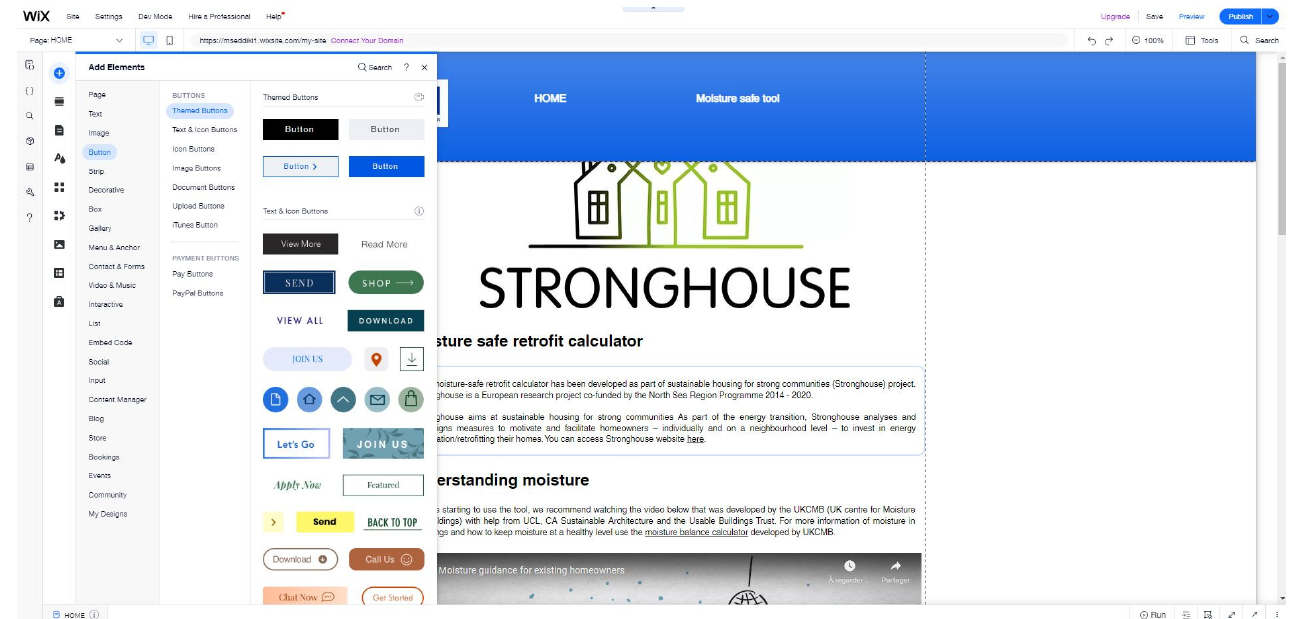
Figure 2. Wix drag-and-drop functionality. The website back end was developed using the content manager Wix